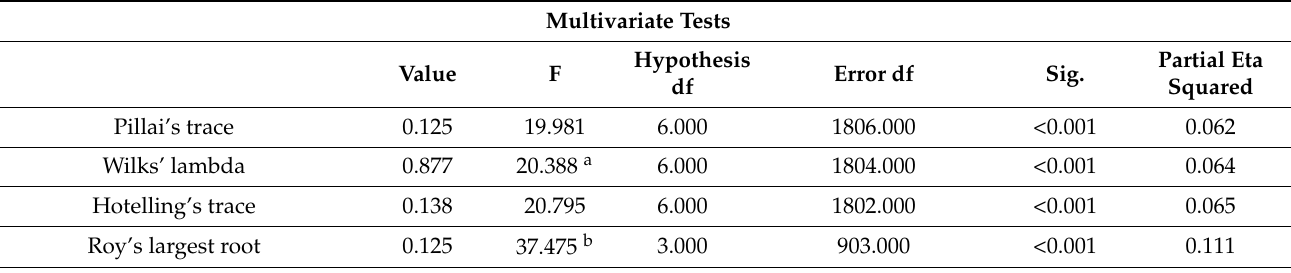
Table 13. Multivariate and univariate test